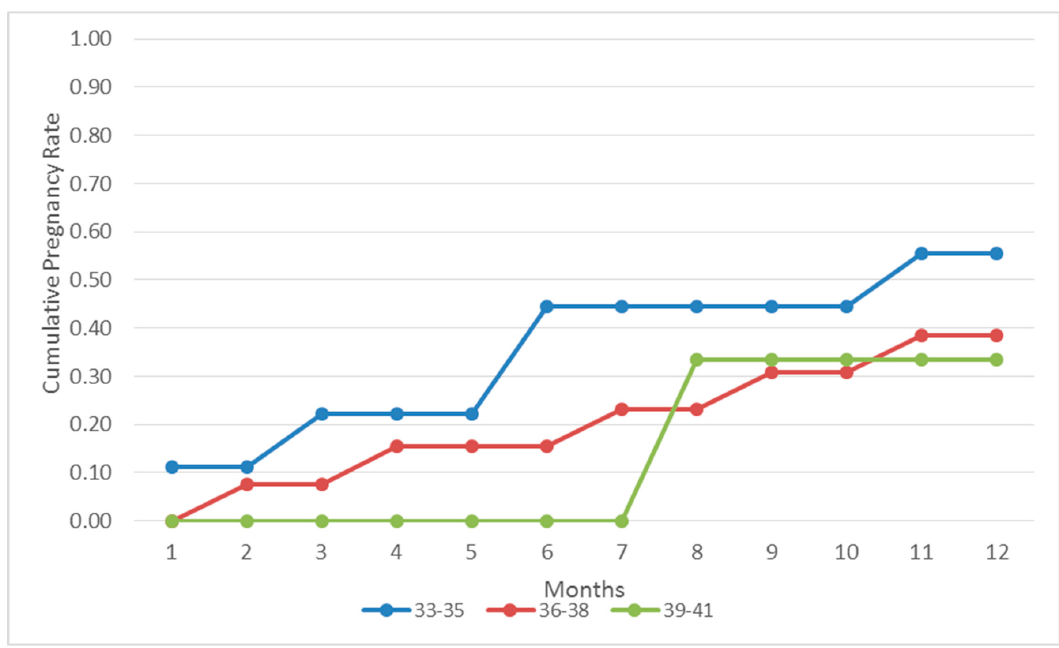
Figure 2. Cumulative pregnancy rates following adhesiolysis per age group during a 12-month period.